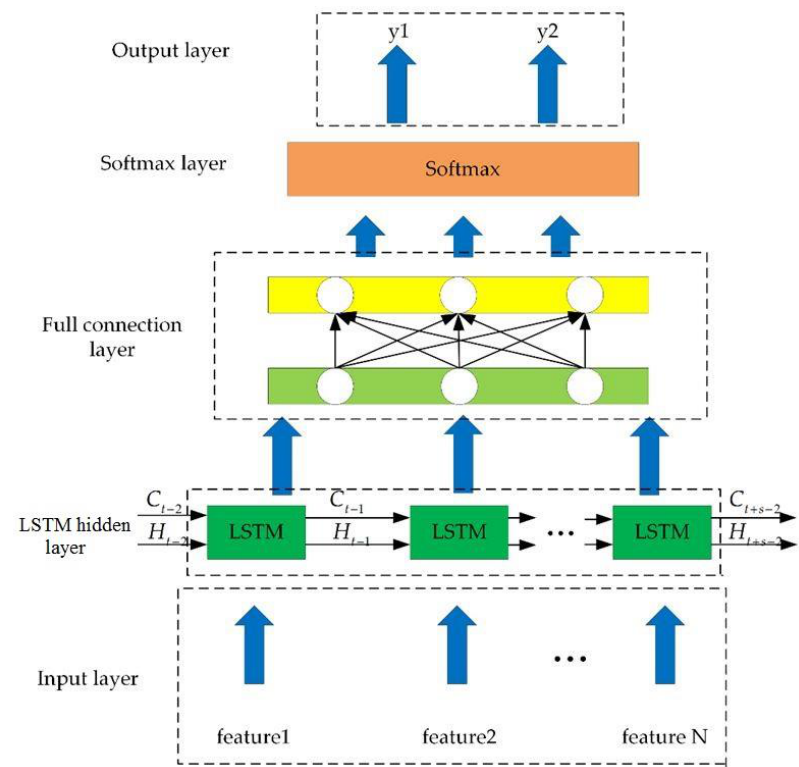
Figure 13. LSTM model structure.